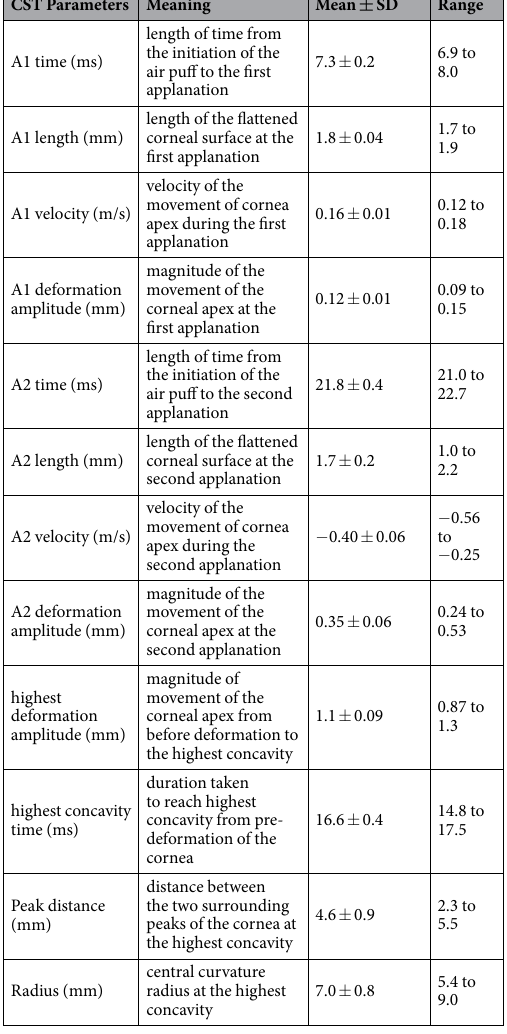
Table 1 summarizes the measured CST parameter values. Characteristics of the study population are summarized in Table 2. Subjects’ average age was 27.7 ± 5.0 (mean ± standard deviation) [range: 21–39] years. The mean axial (Fig. 3). The univariate relationship between cpRNFL peak angle and age, body height, CCT, GAT IOP, axial length and the 12 CST parameters is summarized in Table 3; AL, A1 deformation amplitude and A2 time were significantly correlated with cpRNFL peak angle (p < 0.05). As shown in Table 4, the adjusted R 2 value and the AICc value associated with the multivariate regres- sion model between cpRNFL peak angle against age, body height, CCT and axial length was 0.062 and 904.2, respectively. In this model, only axial length (coefficient = − 4.3, p = 0.030) was a significant predictor of cpRNFL peak angle. The optimum model for cpRNFL peak angle chosen from 2 16 models was: cpRNFL peaks